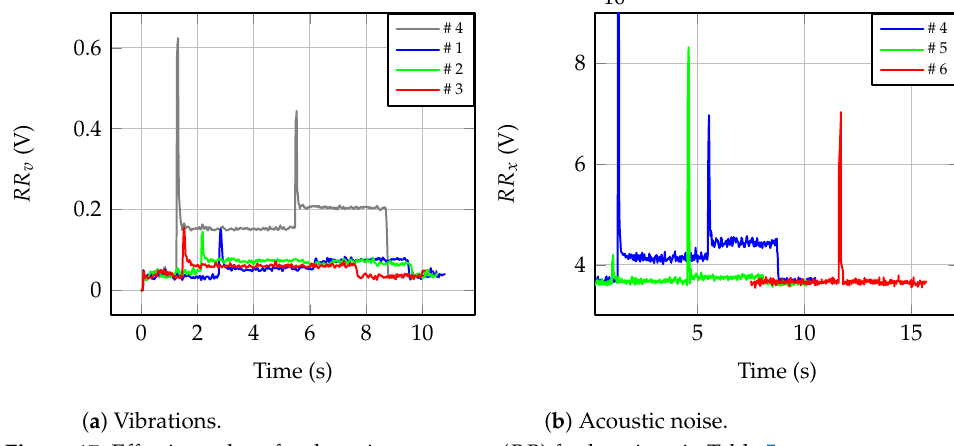
Figure 17. Effective values for detection purposes ( RR ) for locations in Table